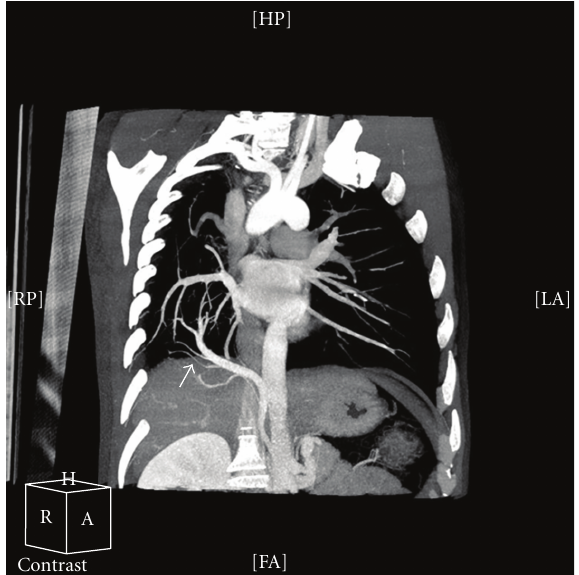
Figure 4: Three-dimensional reconstructed image showing an aortopulmonary collateral artery (white